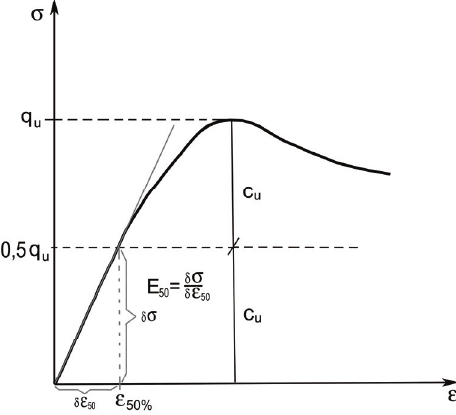
Fig. 1. Derivation of undrained elastic modulus E u 50 from non-linear stress-strain